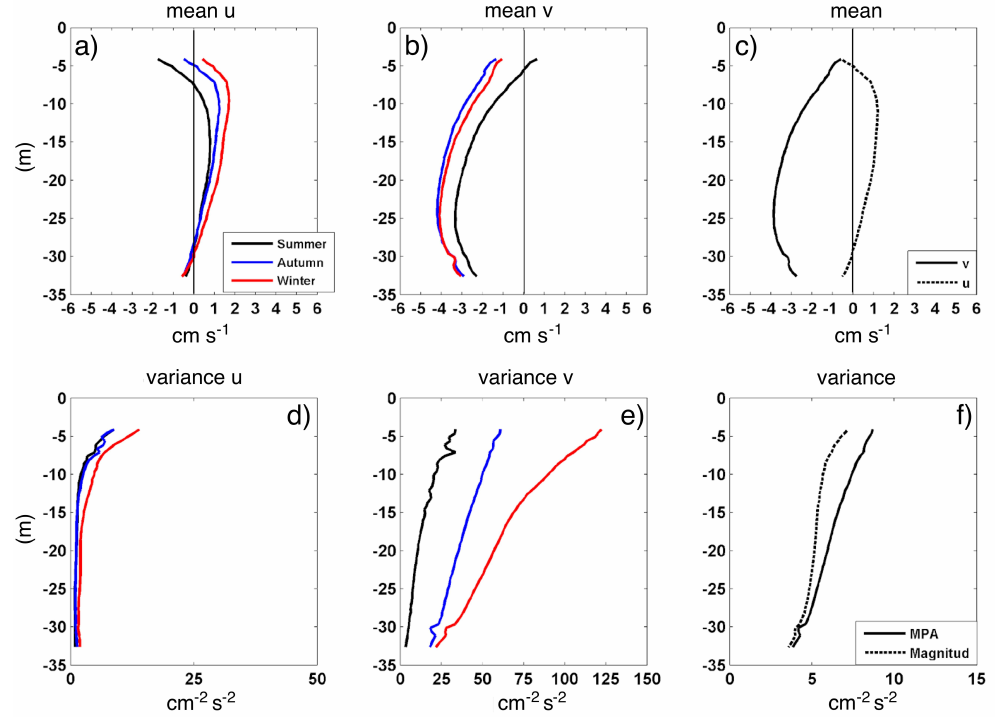
Figure 7. Vertical structure of ( a – c ) mean synoptic currents and ( d – e ) their variance, and ( f ) the amplitudes of the major principal axis (MPA) and the mean